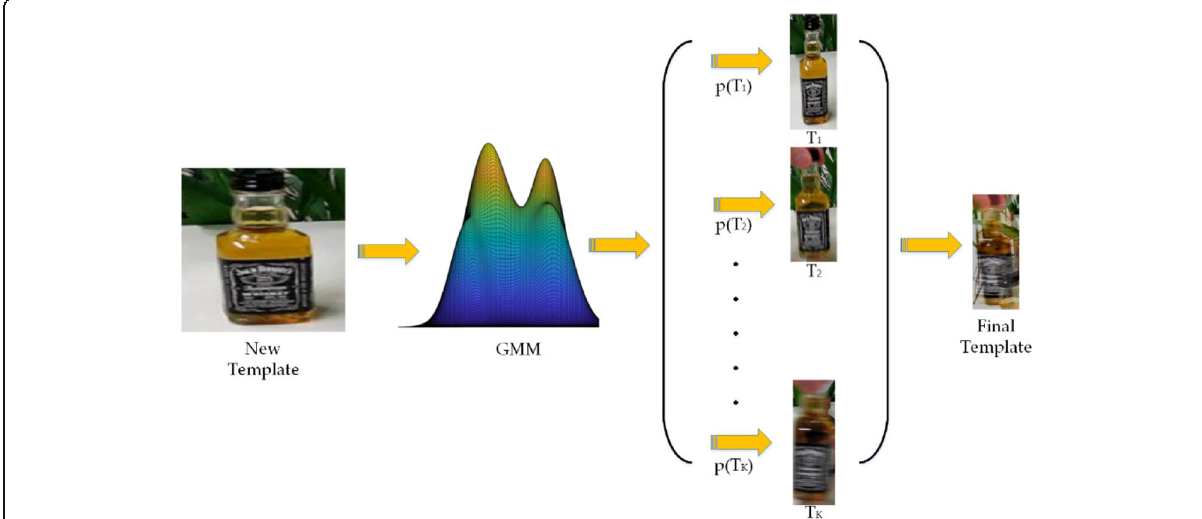
Fig. 5 The illustration of the GMM model for constructing templates. The GMM model utilizes the new template and the probability distribution corresponding to the existing component to construct